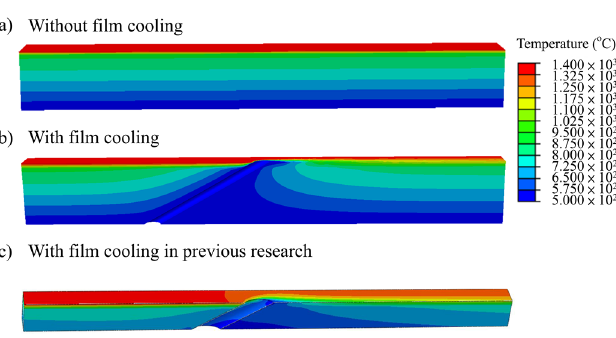
Figure 3. Temperature distribution ( a ) without film cooling, ( b ) with film cooling, and ( c ) compared to previous result [17].